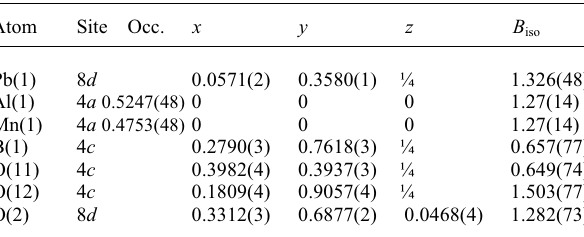
Table 2. Atomic coordinates and displacement parameters (in Å 2 ) . Site